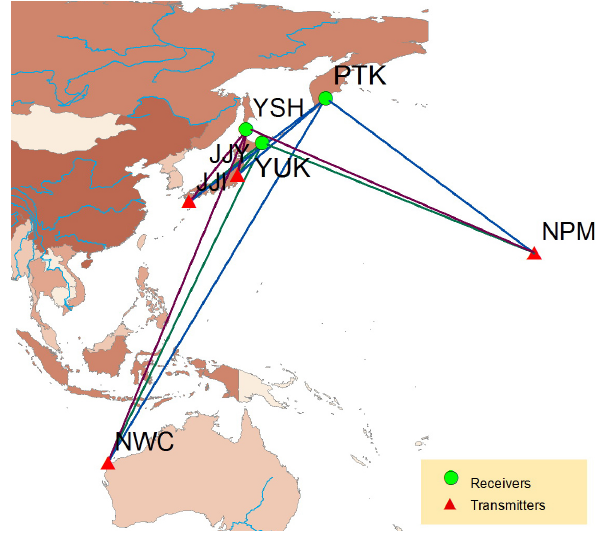
Figure 1. A map showing the position of the receivers in Petropavlovsk-Kamchatsky (PTK), Yuzhno-Sakhalinsk (YSH) and Yuzhno-Kurilsk (YUK), together with the position of the trans- mitters JJI (22.2kHz), JJY (40kHz), NWC (19.8kHz) and NPM